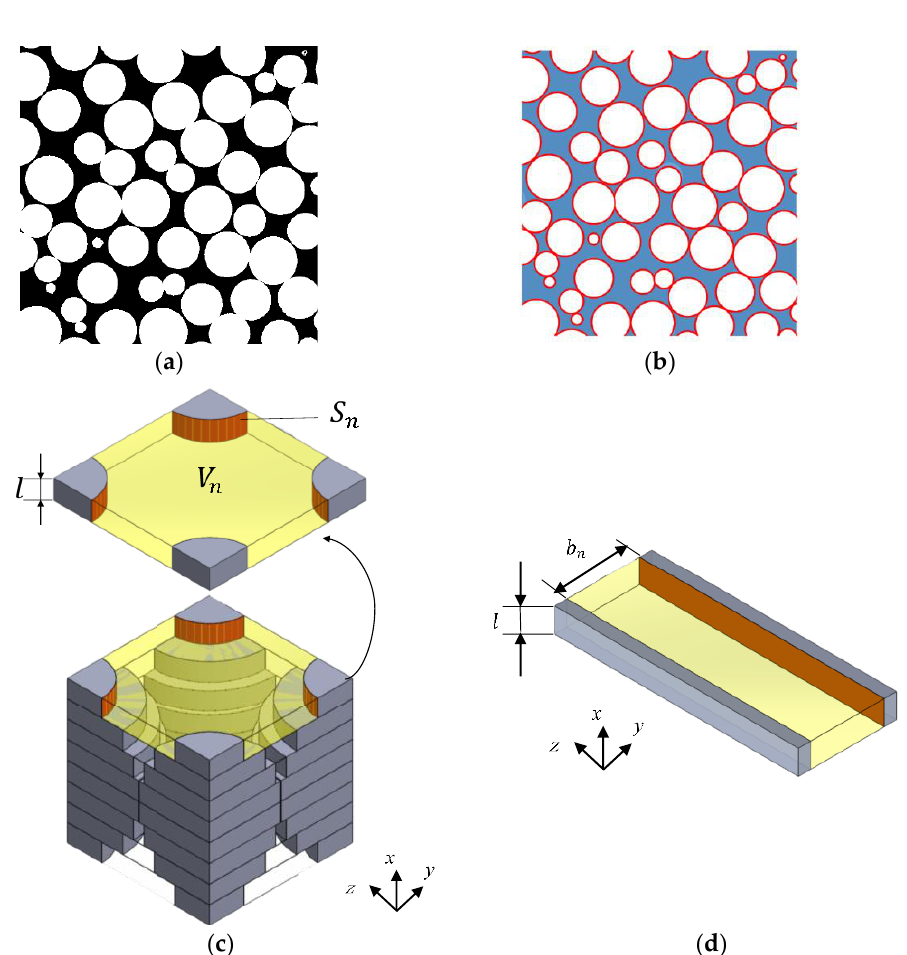
Figure 5. Divided element approximated to the clearance between the two planes: ( a ) binarization of the cross-sectional image; ( b ) calculation of the circumference of the sphere and the cross-sectional area of the clearance; ( c ) divided element; ( d ) approximated clearance between the two planes.